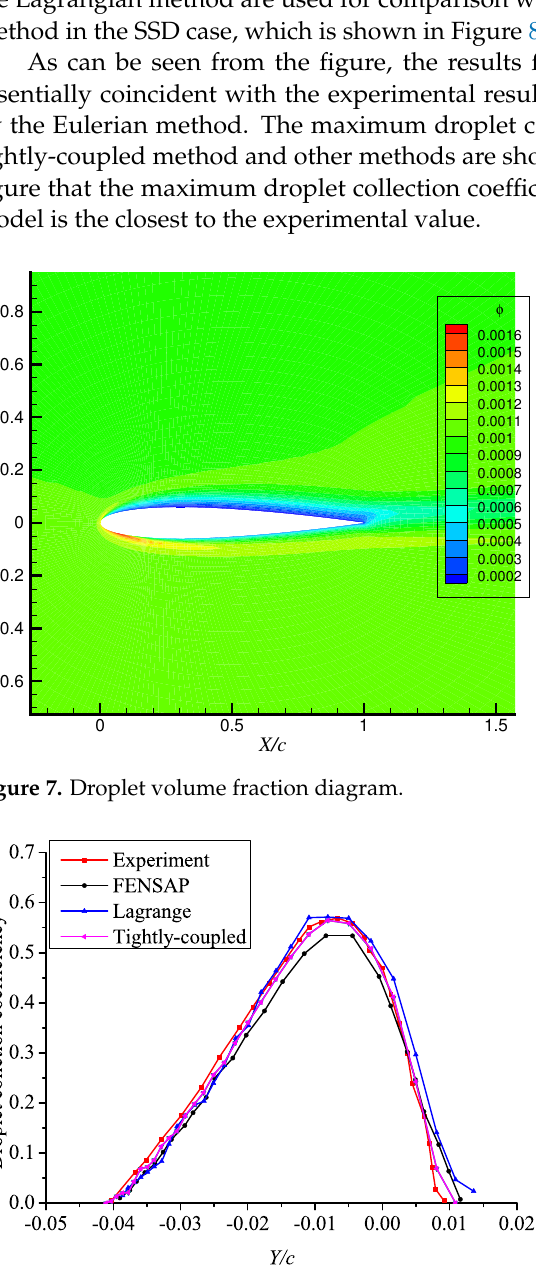
Figure 8. Droplet collection coefficient of the